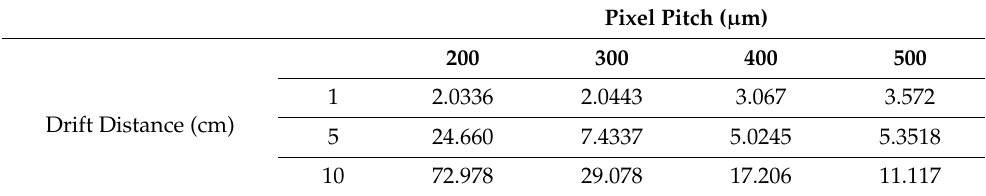
Figure 4. Comparison of the direction model predicting accuracy by energy per drift length for the 500 µ m pitch case. Left column: Cosine of the angle between the true and predicted initial electron recoil directions for the initial direction model at drift lengths 1, 5, and 10 cm. Right column: Magnified view of the left column. Table 2. Median of the angle (in degrees) between the predicted and true initial direction vectors for various pixel pitches and drift lengths. Perfect predictions yield δ = 0 ◦